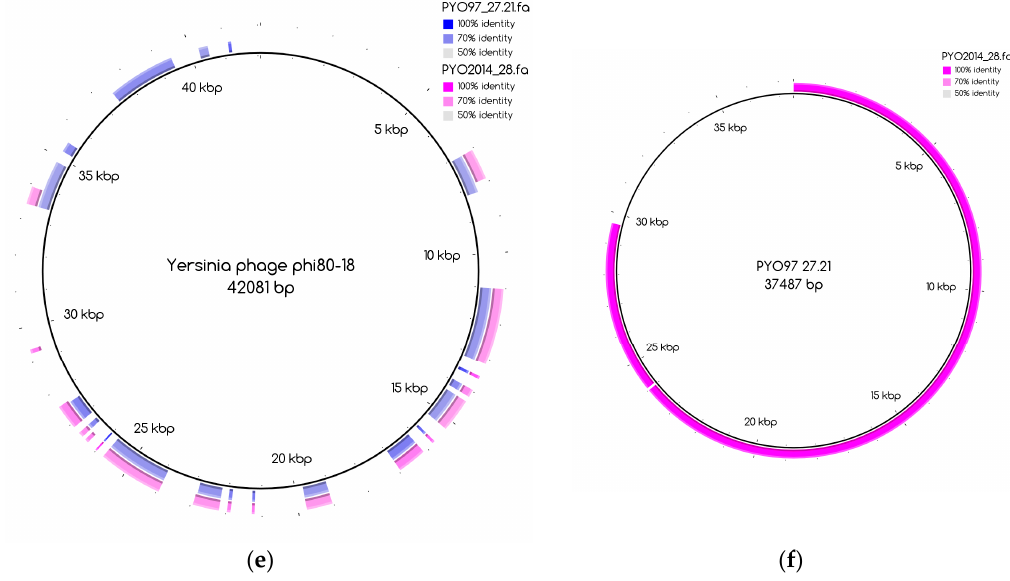
Figure 3. Blast Atlases. ( a ) Example of an original bin, PYO97_10 (coverage 13.9 ± 0.015), that was split into two bins: one made of the contiguous contigs closest to the reference in the middle until the orange contig, bin PYO97_10_85.139.47.48.59.38.5.35.15.78.55.44.14 (coverage 12.4 ± 0.014), and the second one, bin PYO97_10_3.8.10.28.42 (coverage 16.9 ± 0.025), containing the remaining contigs; ( b ) Merging of three bins PYO97_22, PYO97_3 and PYO97_14 into one PYO97_22.3.14 which covers the entire reference genome; ( c ) Collapsed bin in PYO2014; these three contigs have been grouped together to form a collapsed bin. The difference between a normal bin and a collapsed bin is the presence of overlapping contigs in the latter probably derived from shared sequences between species of the same phage family; ( d ) Corresponding draft genomes from the two samples aligning to the reference, Pseudomonas phage TL; ( e ) PYO97_27.21 and PYO2014_28 are highly similar and do not resemble any known sequence; ( f ) Alignment of PYO2014_28 to PYO97_27.21.